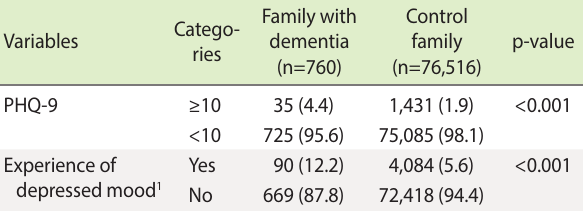
Table 2. Depression question characteristics of the subjects